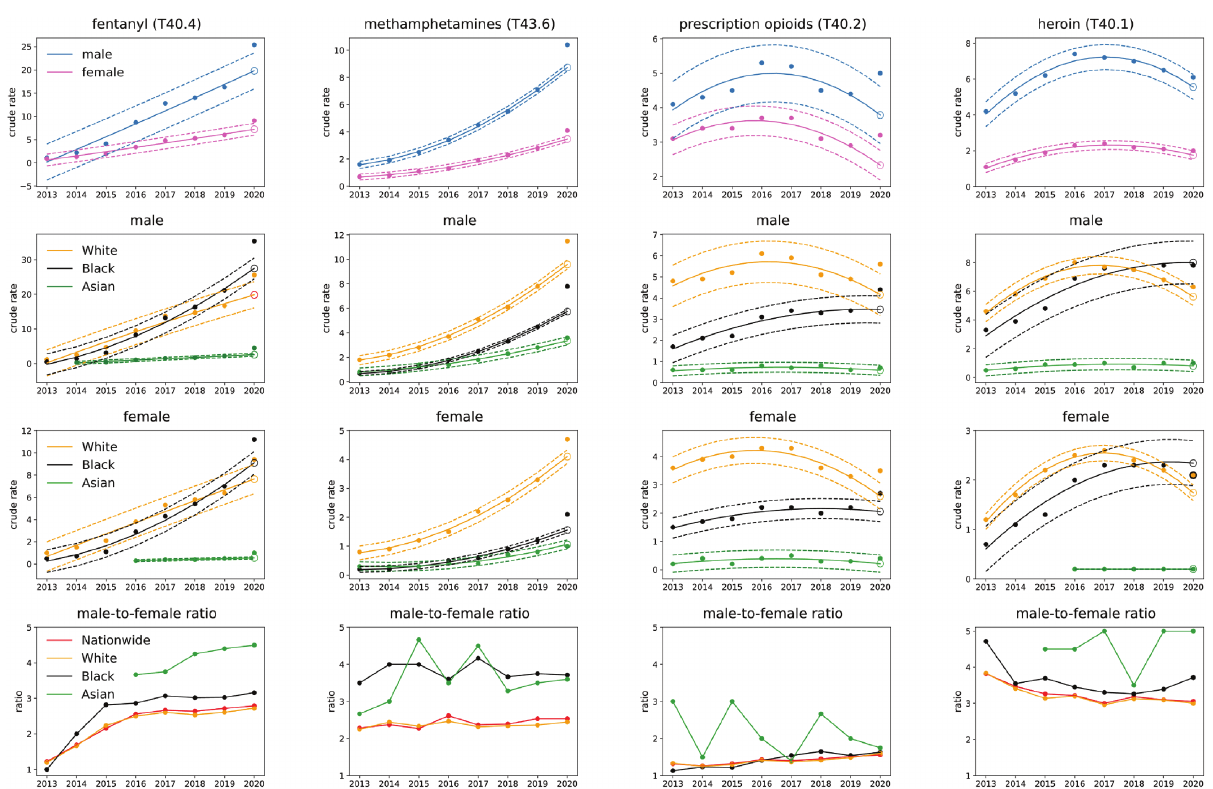
Fig 1. Nationwide gender and race stratified crude rate trends for synthetic opioids (fentanyl, T40.4), psychostimulants with abuse potential (methamphetamines, T43.6), semi-synthetic opioids (prescription opioids, T40) and heroin (T40.1). Solid lines in the upper three rows represent the 2013–2019 quadratic regression; dotted lines correspond to values above and below the regression by three times the standard deviation calculated from 2013–2019 data; the open circle is the 2020 projection. Top row: results are stratified by gender. Note the increasing 2013–2019 trend and the 2020 value exceeding projections for fentanyl (T40.4) and methamphetamines (T43.6) for both genders; crude rates for prescription opioids (T40.2) and heroin (T40.1) have been decreasing but rose again in 2020, with significant rises especially in prescription opioids (T40.2) for both genders. Second (third) row from top: results are stratified by race for males (females). For fentanyl and heroin the Black male crude rate surpassed that of Whites in 2018. Last row: Male-to-female ratio for all races. The ratio for Blacks is higher than the ratio for Whites in all categories except for prescription opioids (T40.2). We include results for Asians in years when data is available; although crude rates are the lowest in the nation, this is the race with the largest male-to-female ratio in all drug